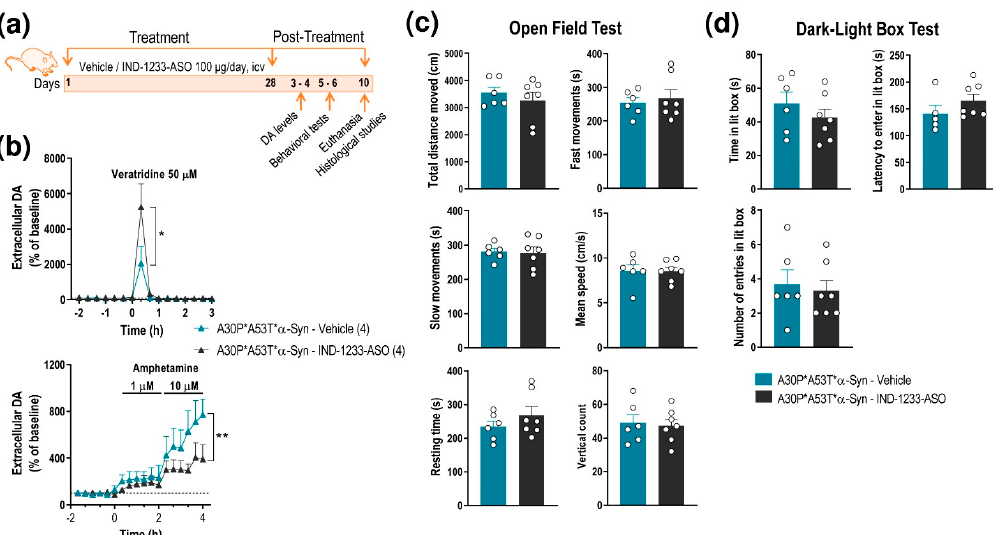
Figure 6. Intracerebroventricular IND-1233-ASO treatment recovers DA neurotransmission deficits, but not behavioral phenotype, in A30P*A53T* α -Syn transgenic mice. ( a ) Treatment timeline. A30P*A53T* α -Syn transgenic mice (4 months of age) received randomly vehicle or IND-1233-ASO (100 µg/day) into the lateral ventricle for 28 days using osmotic minipumps. In a group of mice, DA release was examined using intracerebral microdialysis at 3-4 days post-treatment, while behavioral tests were performed in an additional group at 5-6 days post-treatment. All mice were sacrificed on day 10 post-treatment. ( b ) Microdialysis approach using veratridine and amphetamine agents, as shown in Figure 3, confirmed the normalization of DA neurotransmission in the CPu of A30P*A53T* α -Syn mice treated with IND-1337-ASO (100 µg/day for 28 days) compared with transgenic mice treated with a vehicle. ( c , d ) No significant differences were detected in the open field test (c) or the dark-light box test (d) between both groups treated with IND-1337-ASO or a vehicle. Data are expressed as the mean ± SEM. Number of mice used in each procedure is indicated in parenthesis. Two-way ANOVA and Tukey’s multiple comparisons test, * p < 0.05, ** p < 0.01 compared to A30P*A53T* α -Syn mice treated with a vehicle.